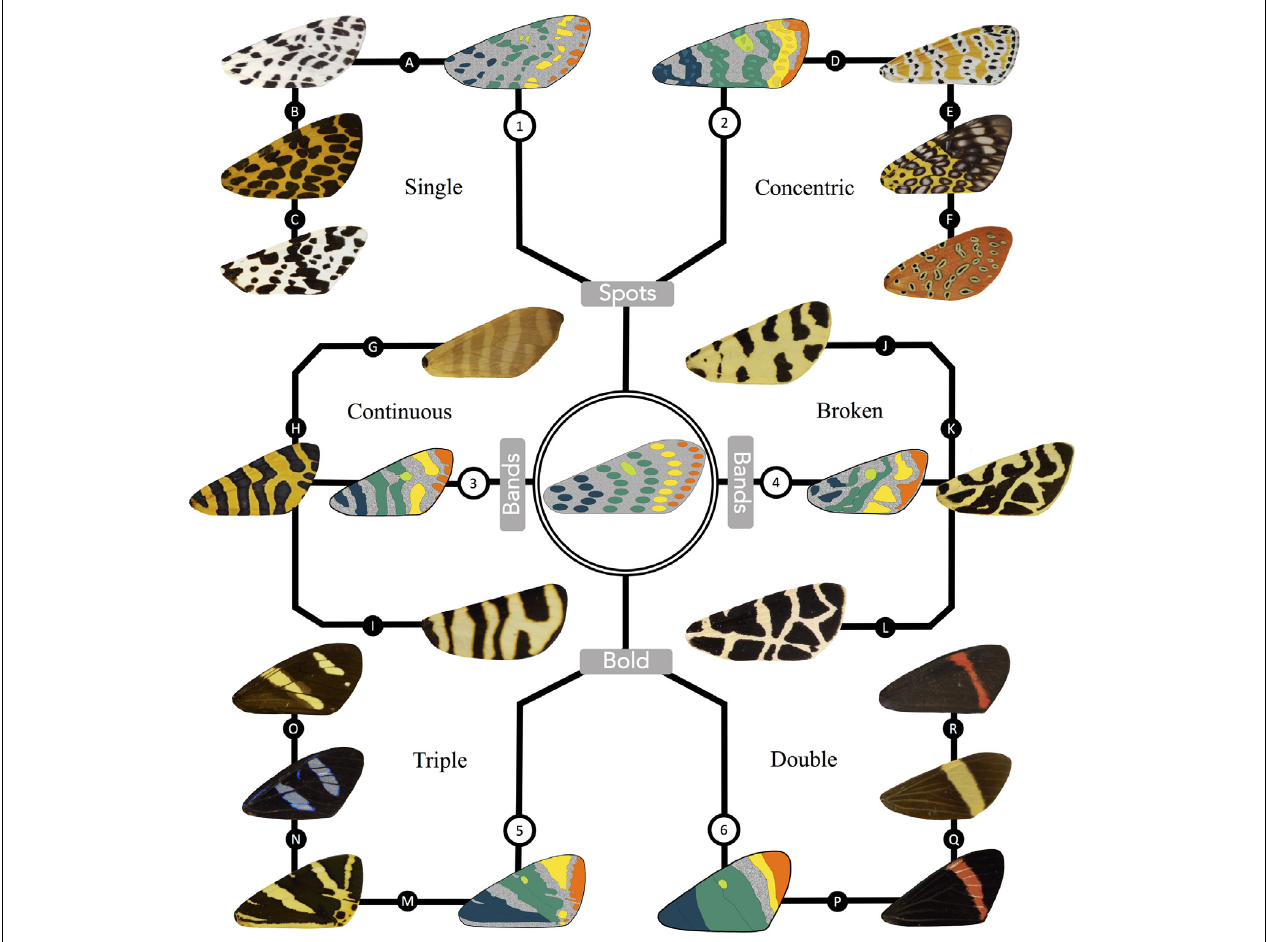
FIGURE 6 | A derivation of the primary types of arctiid patterning from the morphologically simple archetypical characters. The arctiid archetype is depicted in the center of the figure, with six surrounding branches that are representative of the various types of patterning found in the tiger moths. The basal symmetry system, central symmetry system, discal spot, van Bemmelen band, and terminal band (colored blue, green, lime, yellow and orange, respectively) have been identified in one sample species from each of the six types. The top set of branches show animals exhibiting the (1) single spot, and (2) concentric spot phenotypes. Continuous (3) and broken band (4) phenotypes are shown on the branches to the left and right of the archetypical pattern. Bold patterns are depicted at the bottom of the figure. The animals shown in branch (5) exhibit a “triple” bold phenotype, where the primary pattern elements have fused to form three more or less continuous patches. Branch (6) shows animals exhibiting the “double” bold phenotype. In patterns of this type, fusion of the primary characters is more complete, resulting in a pair of dark-colored regions on either side of an isolated island of background coloration. Specimens from the following species are represented in the figure. Group 1: (A) Hypercompe permaculata , (B) Calpenia monilifera , (C) Eucereon coenobita ; Group 2: (D) Utetheisa ornatrix , (E) Sebastia argus , (F) Argina argus ; Group 3: (G) Elysius superbus , (H) Amphicallia thelwalli , (I) Eucharia festiva ; Group 4: (J) Apantesis tigrina , (K) Preparctia romanovi , (L) Apantesis nevadensis ; Group 5: (M) Callimorpha quadripunctaria , (N) Agyrtidia uranophila , (O) Chetone isse ; Group 6: (P) Coreura fida , (Q) Napata jynx , (R) Coreura euchromioides